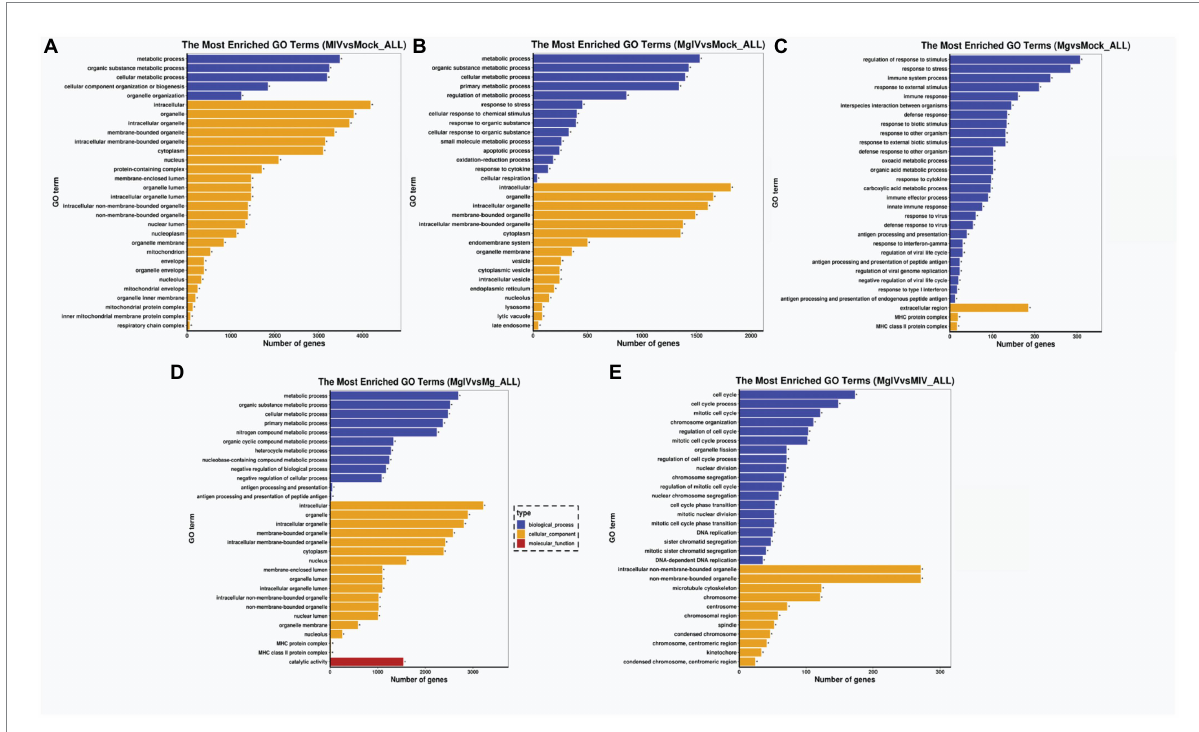
FIGURE 3 GO enrichment analysis of DEGs in different comparison groups. (A) MIV vs. Mock. (B) MgIV vs. Mock. (C) Mg vs. Mock. (D) MgIV vs. Mg. (E) MgIV vs. MIV. p < 0.05; |Log2FC| > 1. GO terms are on the y-axis. Enrichment ratio of genes shown as GO terms for BP, CC and MF. * means GO categories with significant